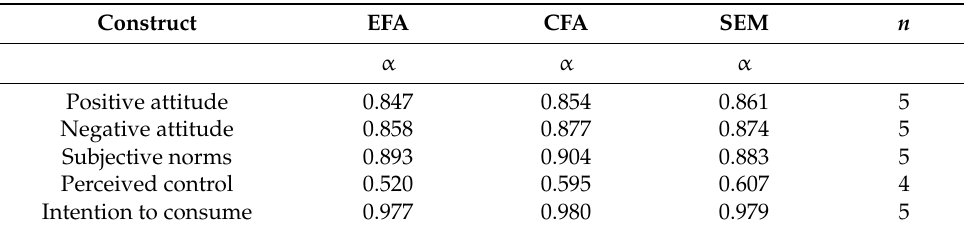
Table 3. Internal reliability statistics (Cronbach’s alpha) for Theory of Planned Behaviour constructs for each